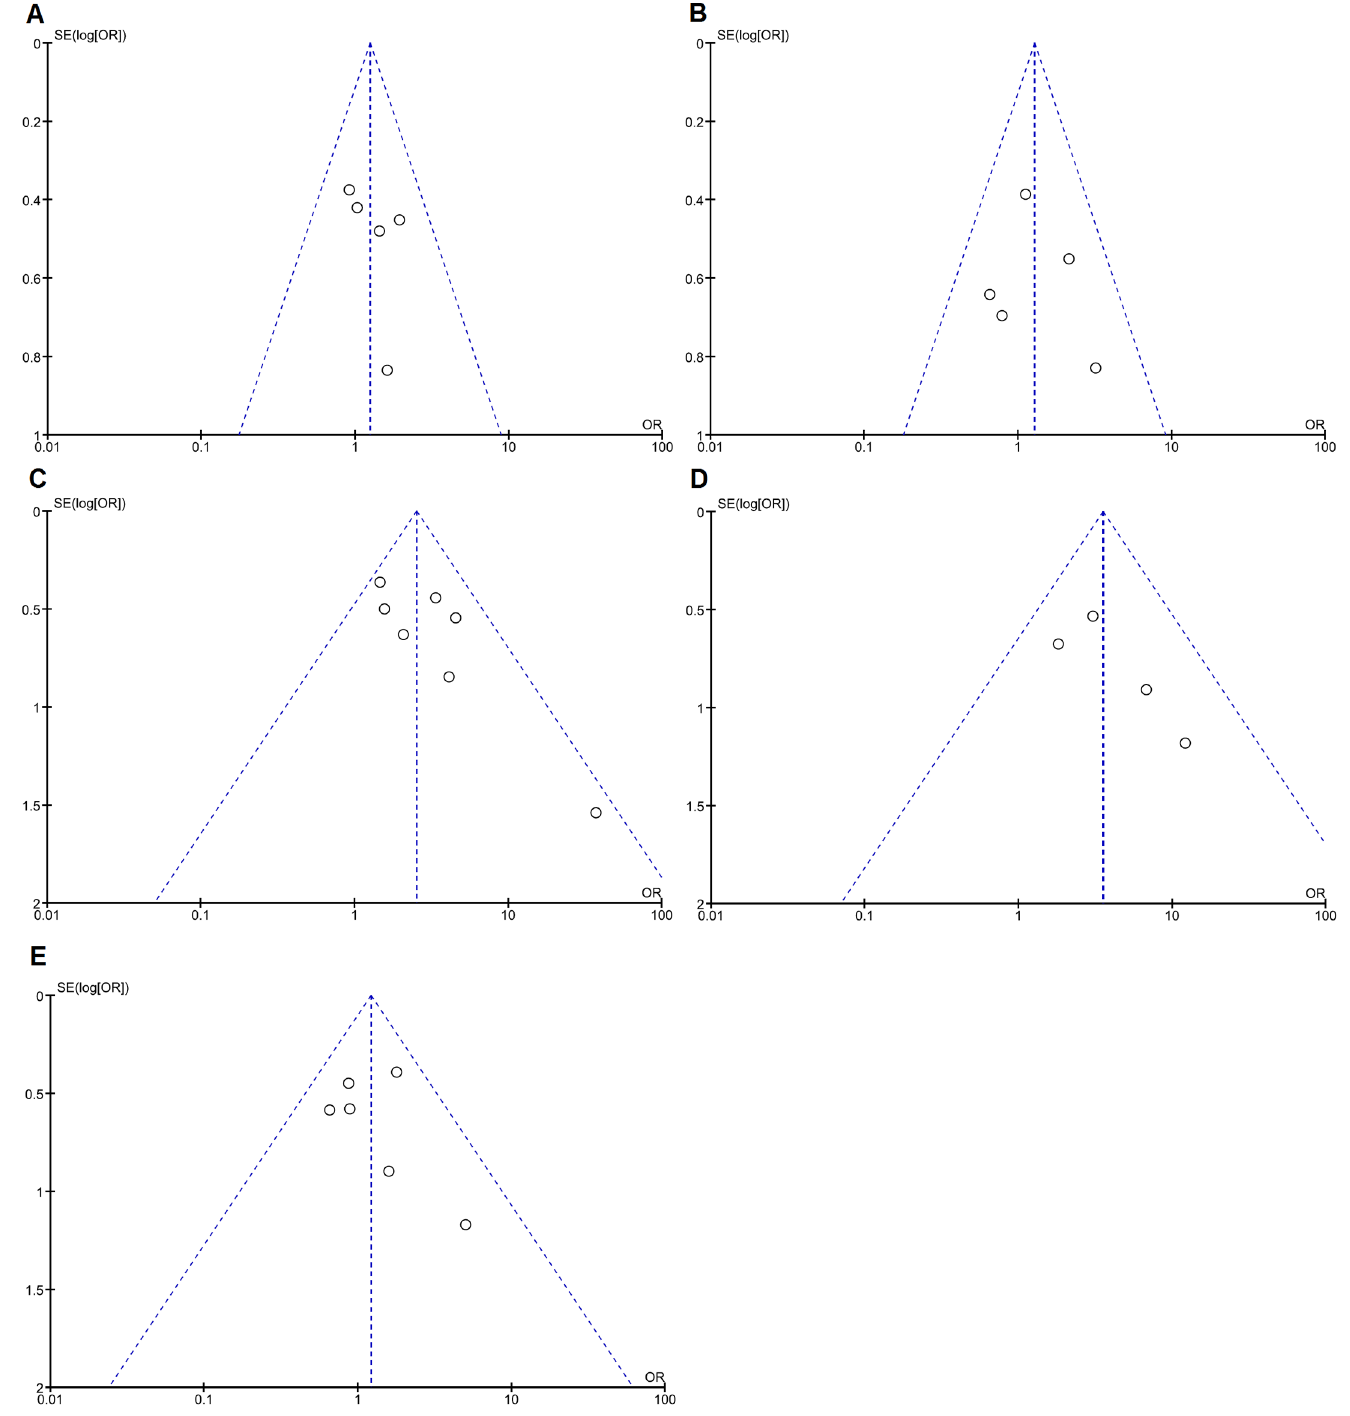
Fig 4. Analysis for potential publication bias. Funnel plots were prepared to assess publication bias with respect to the analyzed variable (A) sex, (B) depth of invasion (T-stage), (C) lymph node metastasis (N-status), (D) UICC tumor stage and (E) grade of differentiation. Y-axis represents the standard error (SE), x-axis represents the study's